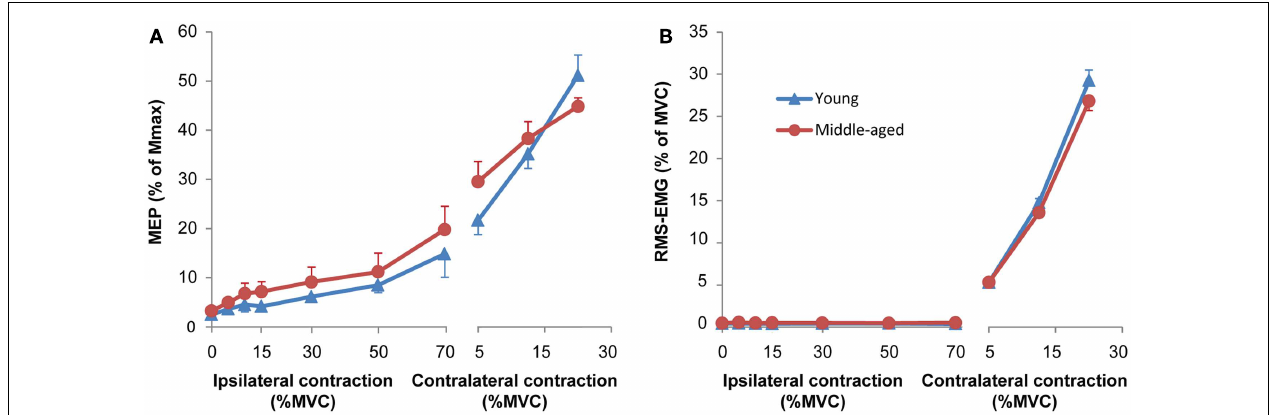
ipsilateral contraction).The MEPs increased with ipsilateral and contralateral force without significant difference between young and middle-aged subjects. (B) Mean and standard error of RMS-EMG (100ms before MEP) upon which the MEPs were evoked at increasing force levels of the hand ipsilateral to the motor cortex receiving theTMS pulse (left panel) and the contralateral hand (right panel) for young (blue) and middle-aged subjects (red).The background RMS-EMG was close to zero during the ipsilateral contraction and increased proportional with the force during the contralateral contraction. No differences were observed between young and middle-aged